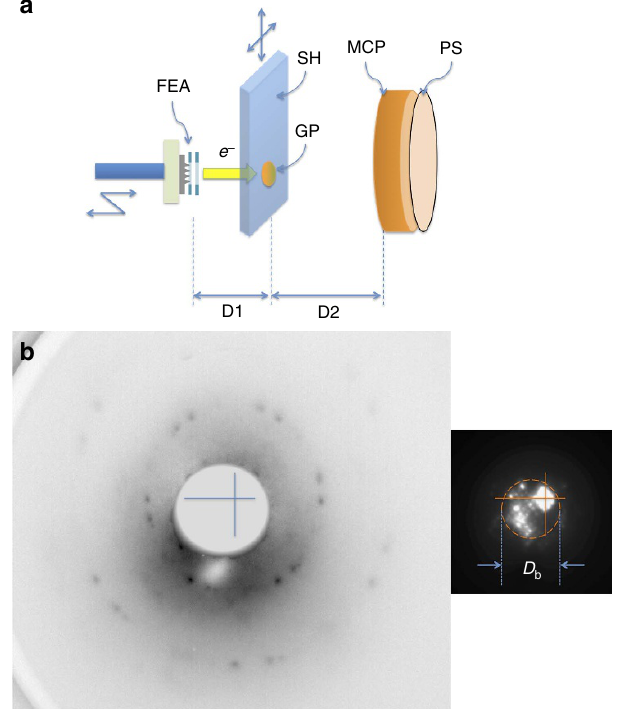
Figure 5 | Low-energy electron diffraction of graphene using a double-gate FEA. ( a ) Schematic of the low-energy electron diffraction experiment. The double-gate FEA (FEA) was separated from the graphene (GP) sample on a TEM grid with the distance of D1 ¼ 7.1mm (the distance 4.6mm between FEA and the sample holder (SH) and the thickness of SH equal to 2.6mm). The transverse position of GP was adjusted by a manipulator. The FEA beam transmitted through and diffracted by GP was detected by the phosphor screen (PS) after amplified by a single-stage multi-channel plate (MCP). GP and MCP were separated by D2 ¼ 29mm. GP and SH was biased at 1kV. The GP side of MCP surface was biased at 250V. ( b ) The electron diffraction of a graphene film generated with the maximally collimated beam ( k col ¼ 1.0) produced from the double-gate FEA. The direct beam (right panel, same spatial scale with the diameter D b E 1mm on the sample) was subtracted and the intensity was factor of a 100 enhanced numerically. The centre of the hexagonal diffraction spots is denoted by a cross: a small graphene domain at the centre of the cross, which was smaller than the bright spot size, contributed the